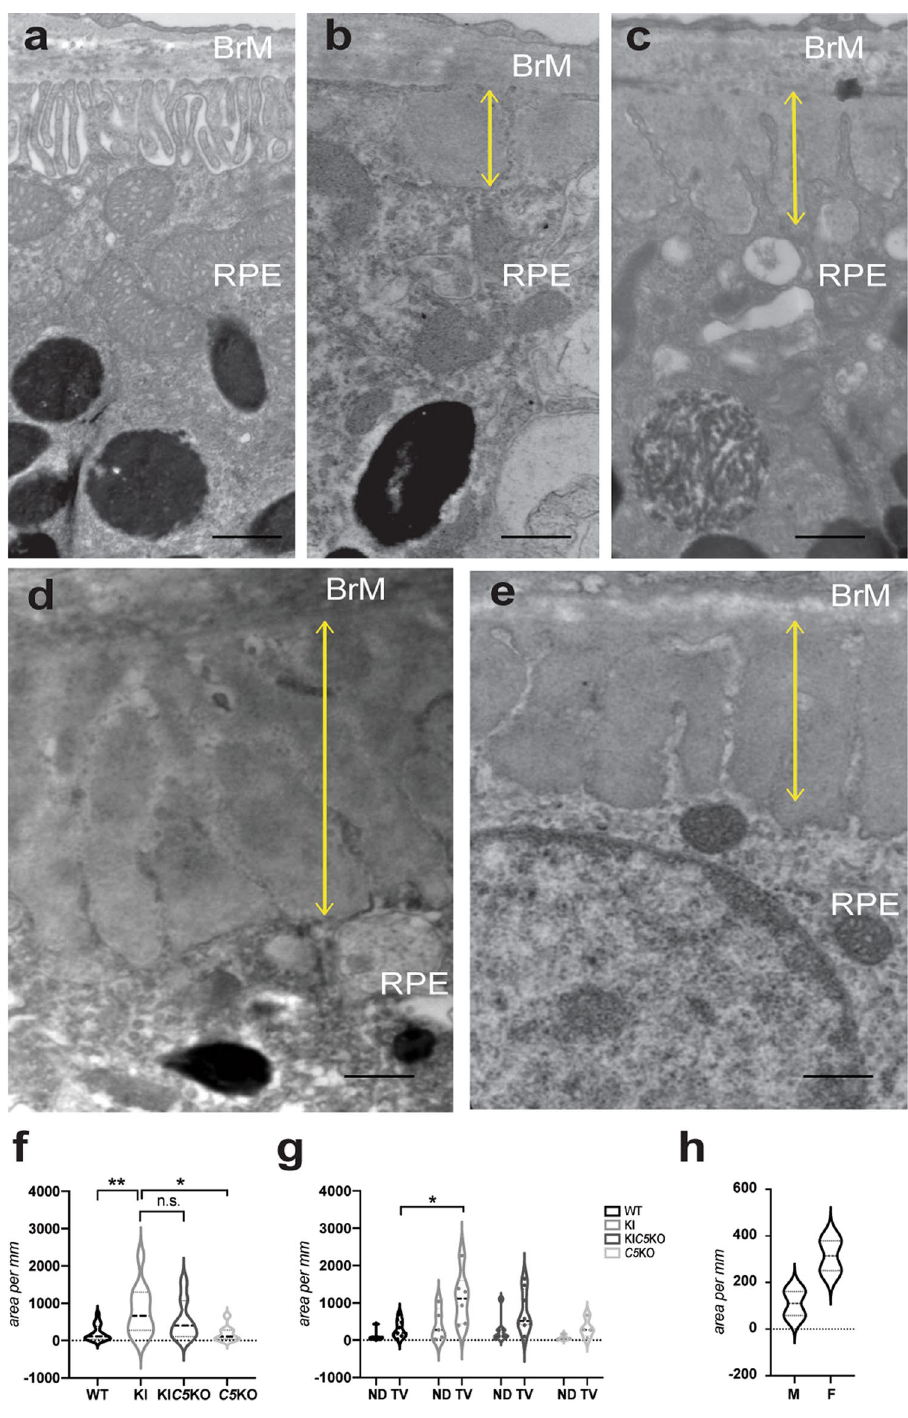
Figure 1. Transmission electron micrographs (TEM) of sub-RPE basal laminar deposits. ( a ) RPE with typical basal infoldings in Efemp1 WT/WT :C5 + / + mice. With age, control mice may show some regions where basal infoldings are disrupted or missing and small sub-RPE deposits are observed: ( b ) Efemp1 WT/WT :C5 + / + ( c ) and Efemp1 WT/WT : C5 -/- . ( d ) Larger, more frequent sub-RPE deposits are observed in Efemp1 R345W/R345W , and ( e ) Efemp1 R345W/R345W : C5 -/- mice of the same age. Yellow lines mark the depth of the basal deposits. Scale bar = 500 nm. ( f–g ) Graphic representation of sub-RPE deposits measured as deposit area per mm length of retinal sections analyzed by TEM (average ± SD) in mice of all genotypes at 14–18 months of age. ND: nasal-dorsal, TV: temporal-ventral. ( h ) Violin plots represent the quantification of sub-RPE deposits in male vs. female Efemp1 R345W/R345W mice at 12 months as deposit area per mm of retinal section analyzed by TEM. Note that the means of cumulative areas for the deposits at 14–18 months ( f–g ) are substantially larger than at 12 months ( g ). This growth rate has been reported before. F: female, M: male. Statistical analysis by 2-way ANOVA. **p < 0.01, * p < 0.05, n.s. = non-significant. N = 9 Efemp1 WT/WT :C5 + / + (WT), n = 6 Efemp1 R345W/R345W : C5 +/+ (KI), n = 8 Efemp1 R345W/R345W : C5 -/- (KIC5KO), n = 4 Efemp1 WT/ WT : C5 -/-